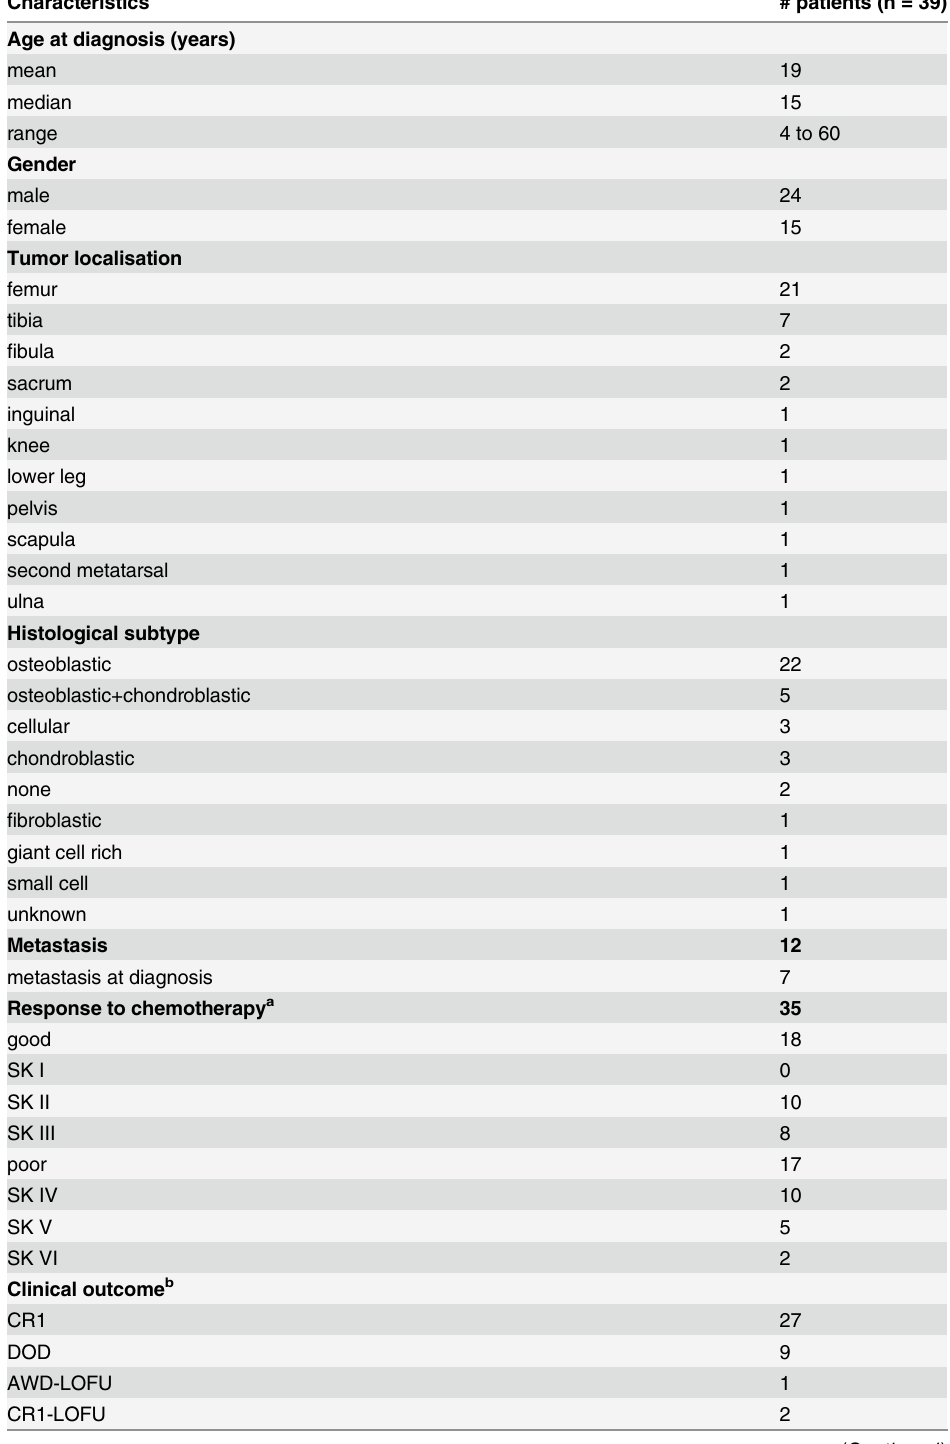
Table 2. Clinicopathological patient characteristics